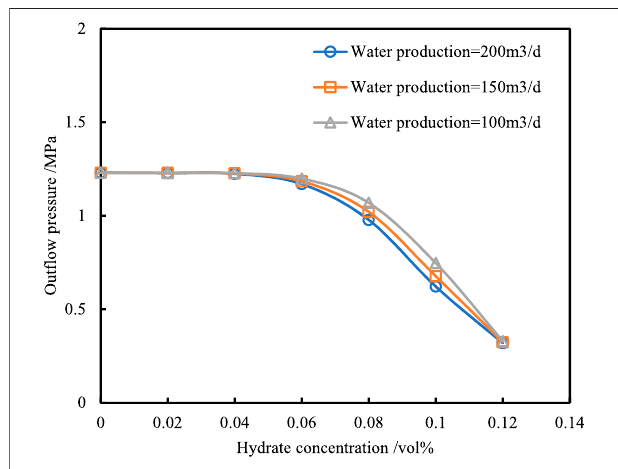
FIGURE 7 | The out fl ow pressures along hydrate concentrations under varied water production